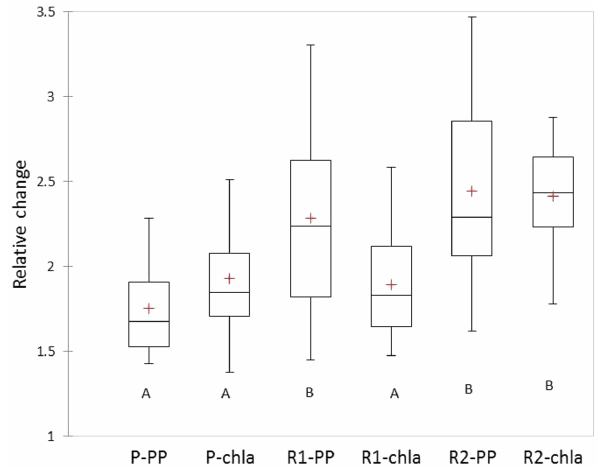
Figure 5. Box plot of the relative changes in integrated Chl a (Chl a dust / Chl a control ) and PP (PP dust / PP control ) over the dura- tion of the DUNE-1-P, DUNE-2-R1 and DUNE-2-R2 experiments. Means that were not significantly different between the different parameters and experiments ( p > 0 . 05) are labeled with the same